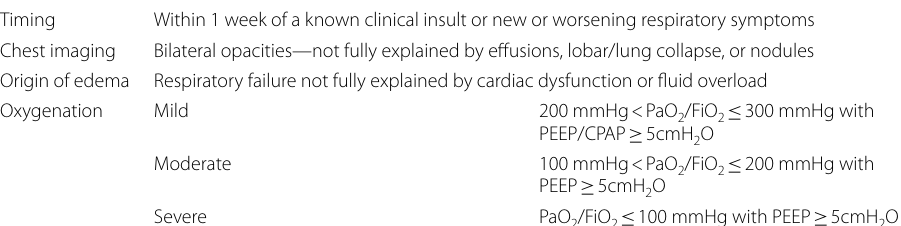
Timing Within 1 week of a known clinical insult or new or worsening respiratory symptoms Chest imaging Bilateral opacities—not fully explained by effusions, lobar/lung collapse, or nodules Origin of edema Respiratory failure not fully explained by cardiac dysfunction or fluid overload